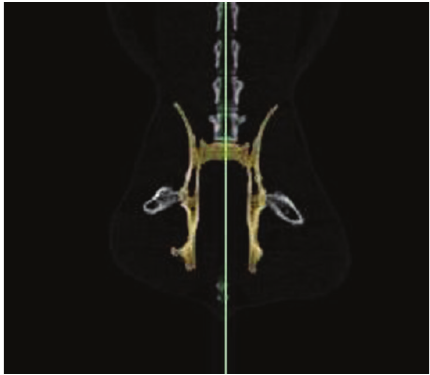
Figure 1: Colored designation of pelvis limits on coronal